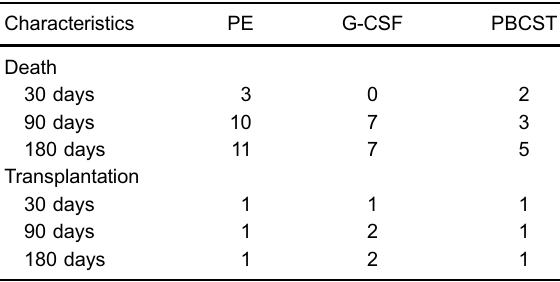
Figure 4. Survival curve analysis at 30, 90, and 180 days of plasma exchange (PE), granulocyte colony-stimulating factor (G-CSF), and peripheral blood stem cell transplantation (PBSCT) groups. A , There were no signi fi cant differences in 30-day survival among the three groups (P=0.103). B , There were signi fi cant differences in 90-day survival among the three groups (P=0.034). There was a signi fi cant difference in 90-day survival between the PE and PBSCT groups (P=0.021). C , There were no signi fi cant differences in 180-day survival among the three groups (P=0.051). Table 2. Deaths and transplantation in the three groups (n=20/ group).